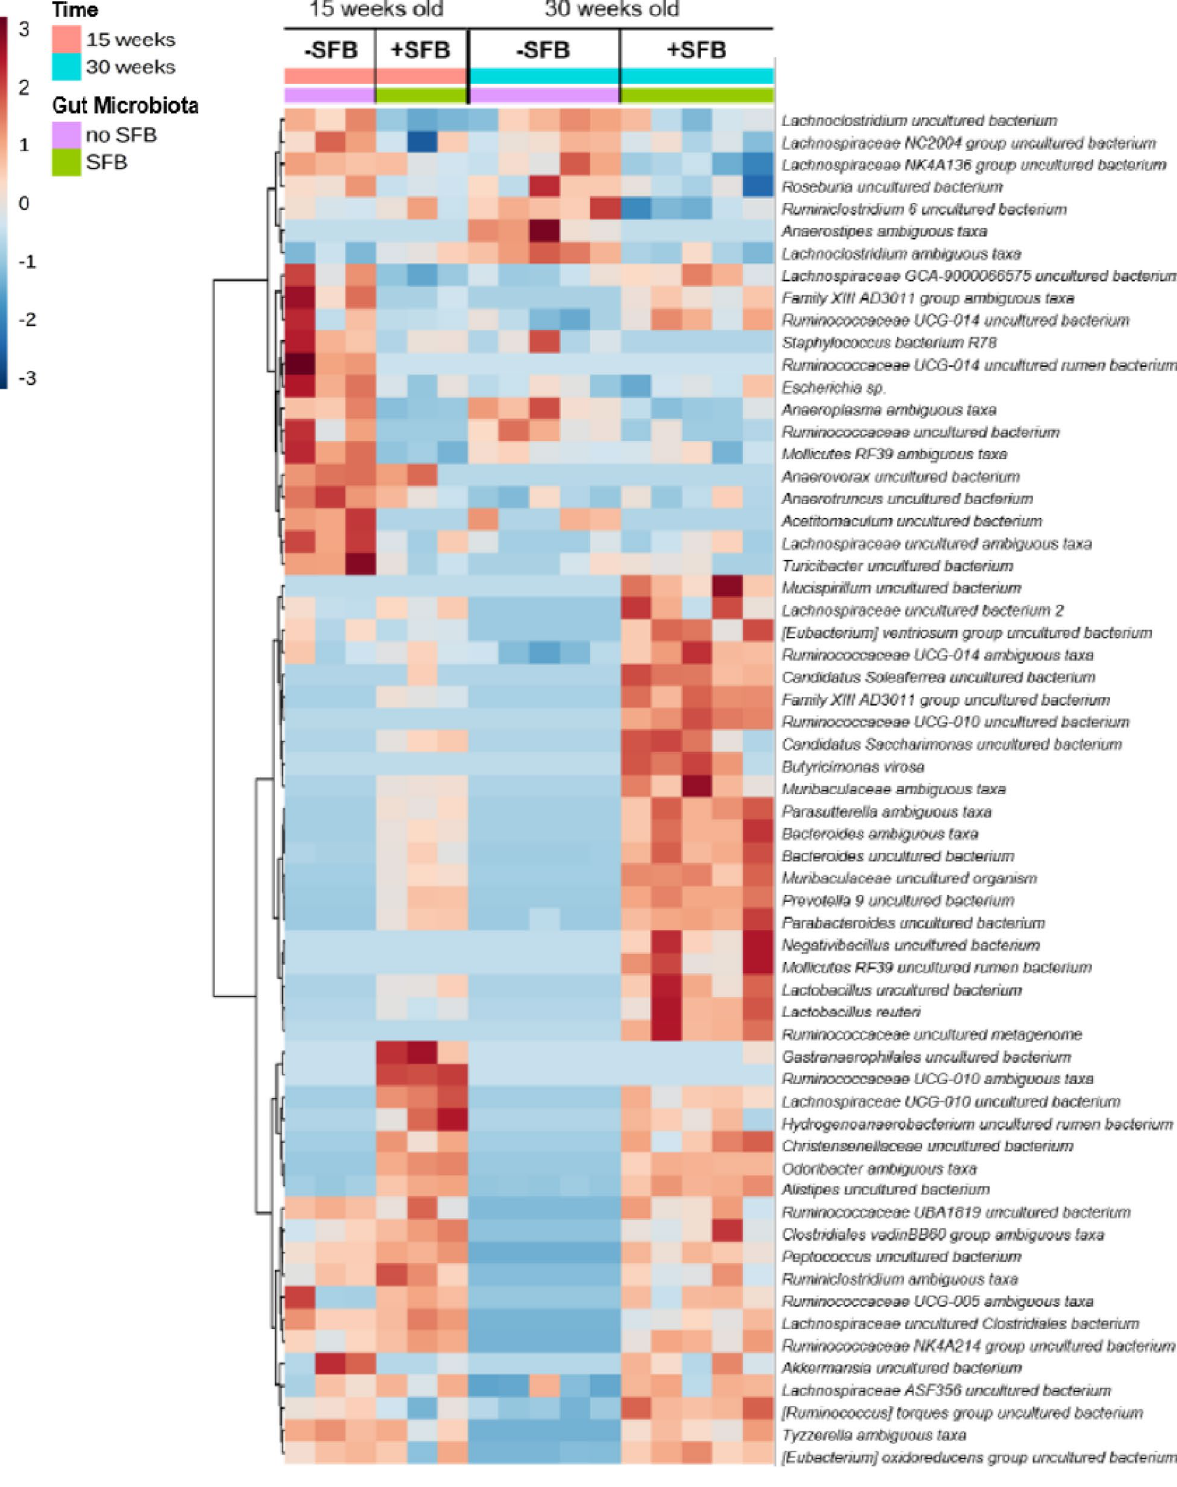
Figure 5. Hierarchical cluster analysis of statistically significant operational taxonomic units (OTUs) in each group based on the presence of SFB and time. Color intensity indicates Log2 normalized abundance of OTUs in each sample. Color coded bars at top indicate SFB status and time of sample